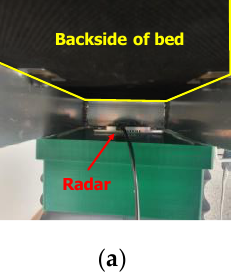
Figure 10. The extracted waveform of ( a ) respiration and ( b ) heartbeat from measured raw data of radar.